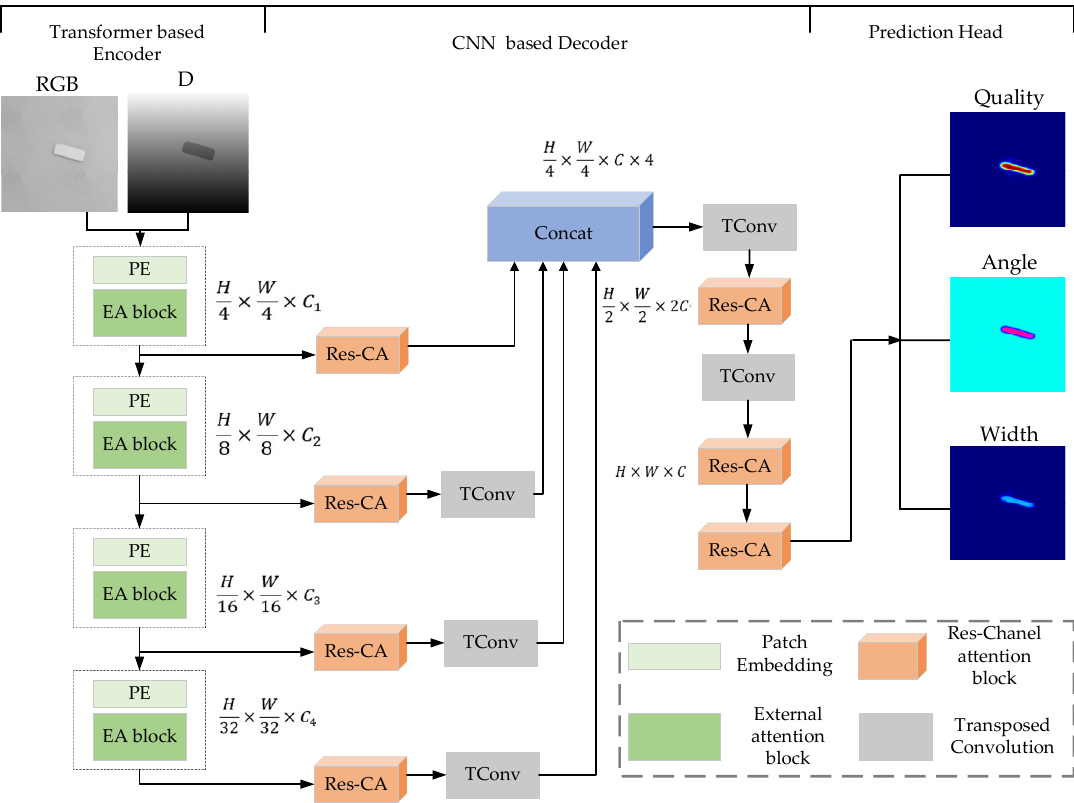
Figure 1. Overview of HTC-Grasp. H and W in the figure correspond to the height and width of the feature map. C i is the channel size of the feature